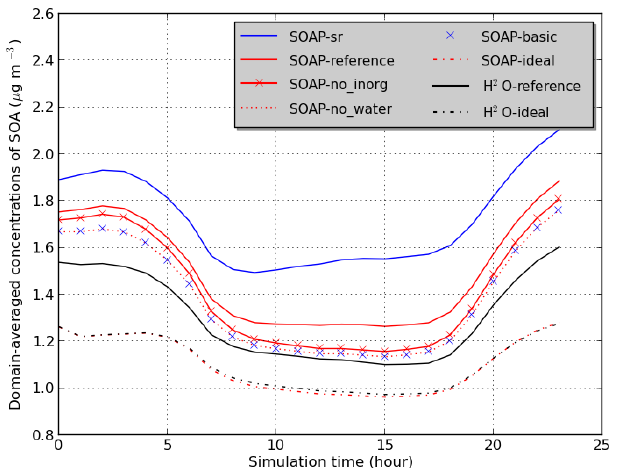
Figure 3. Temporal variation of the average SOA concentrations over the domain (see Table 2 for the description of